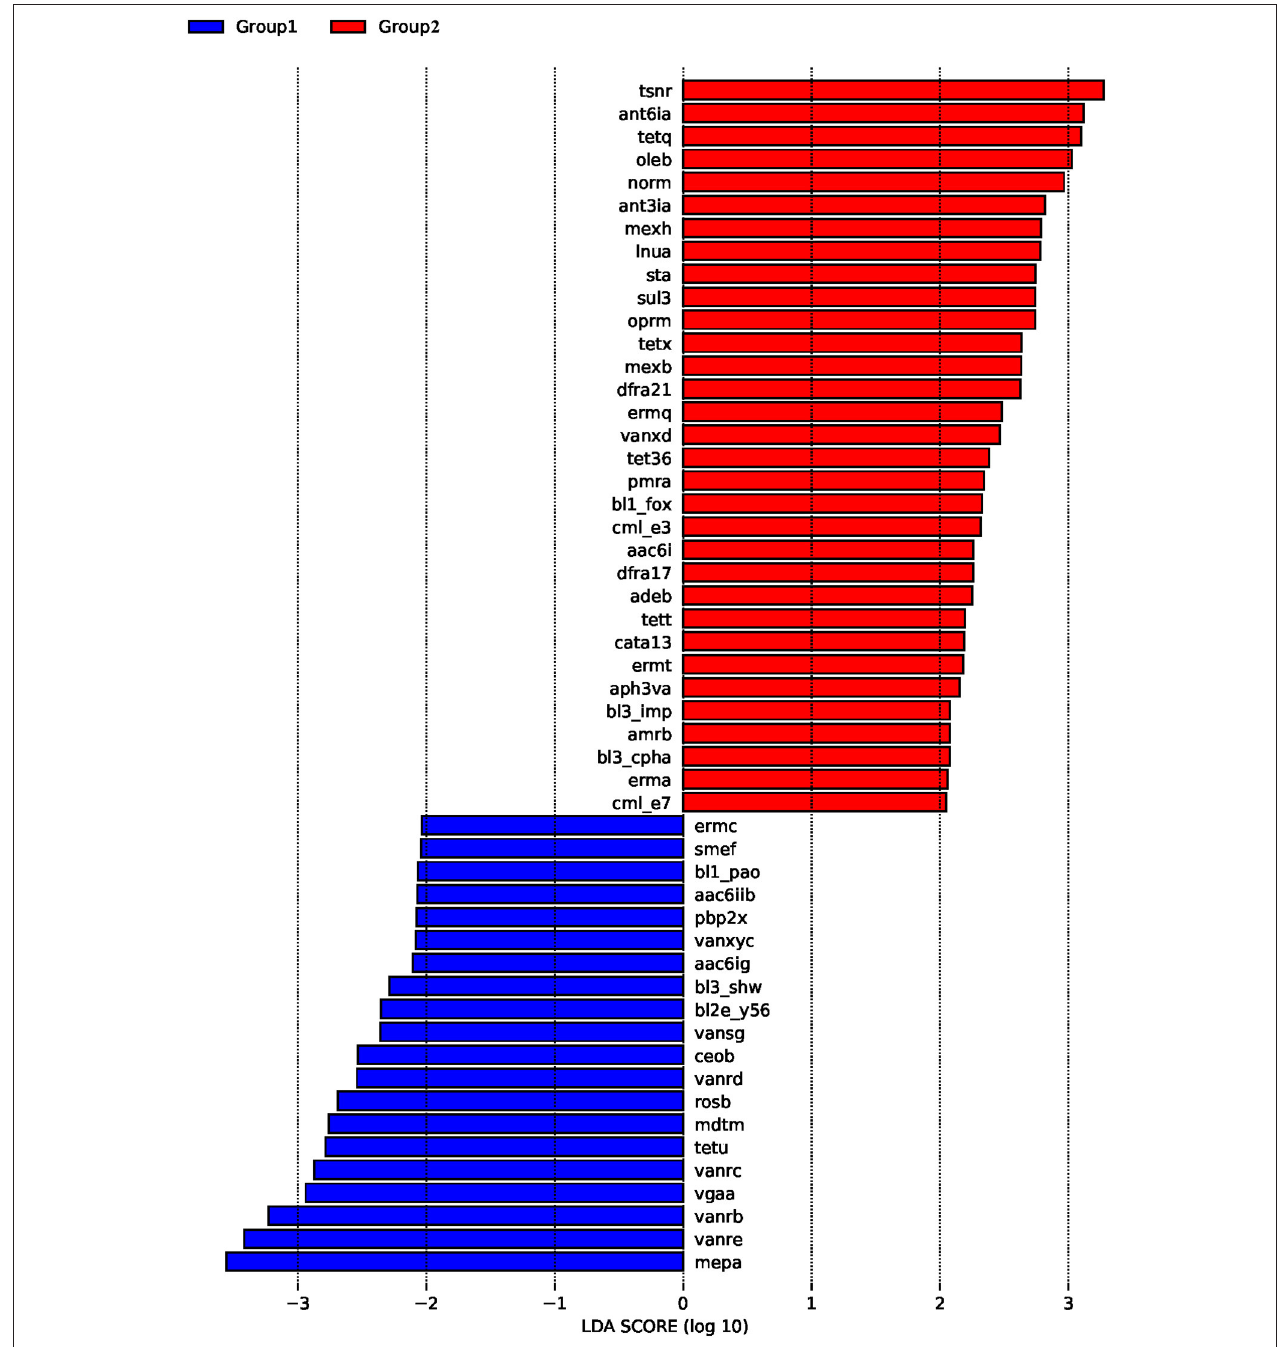
FIGURE 3 | The effects of colistin on ARDB changes. Gut microbiome ARDB changes were analyzed by LEfSe. Group 1, control group; group 2, the colistin